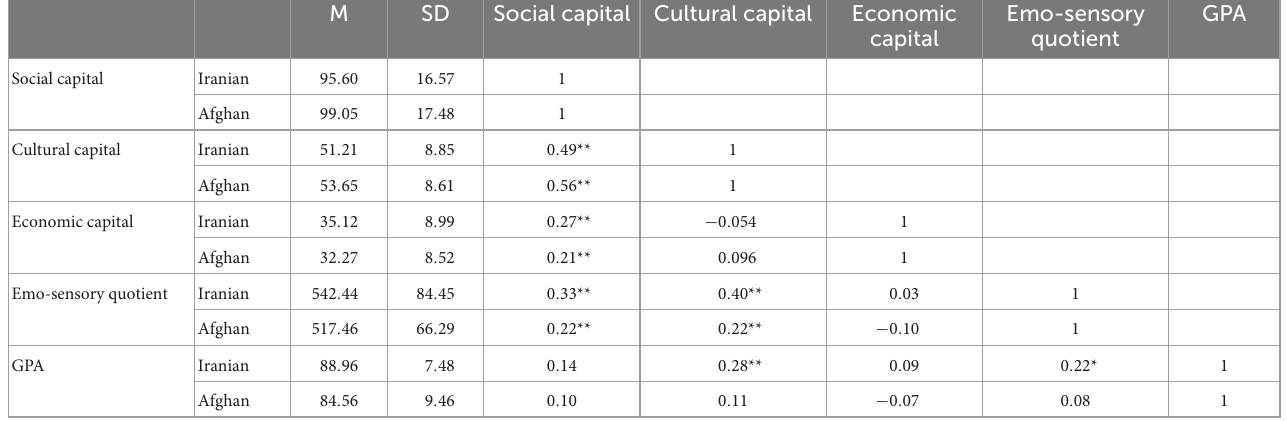
TABLE 5 Descriptive statistics and correlations among economic, cultural and social capitals, emo-sensory quotient, grade point average (GPA) for Iran and Afghanistan. M